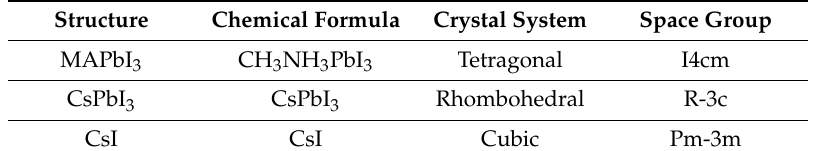
Table 1 . Crystal data of CsPbI 3 & MAPbI 3 . Table 1. Crystal data of CsPbI 3 & MAPbI 3 .